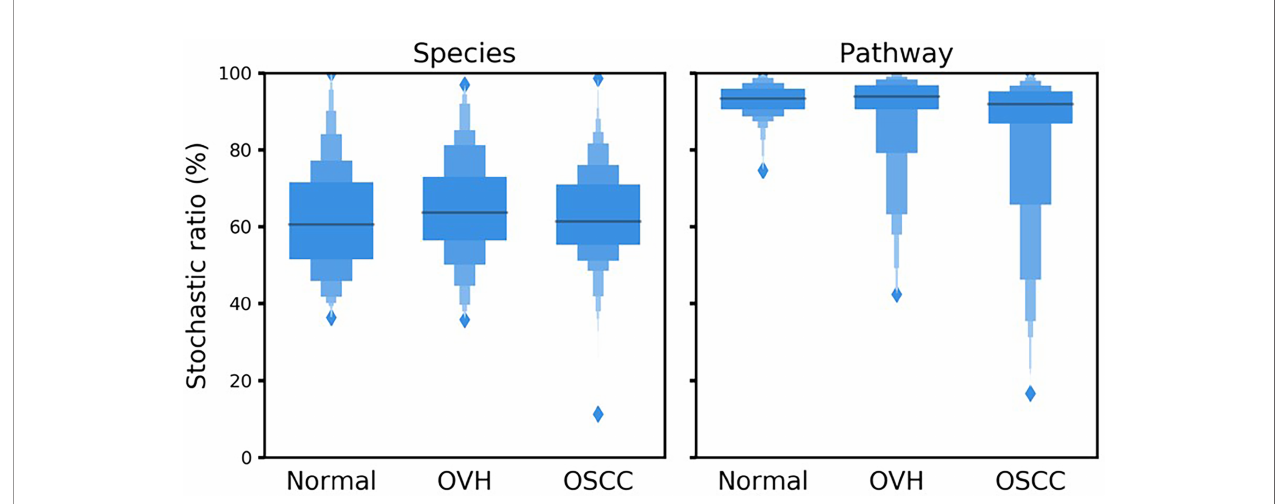
FIGURE 5 | Boxplots illustrate the null-model-based stochastic ratio of microbial taxonomic composition and functional pro fi le based on Bray – Curtis dissimilarities. The simulated procedure was repeated 999 times with proportional occurrence frequency and